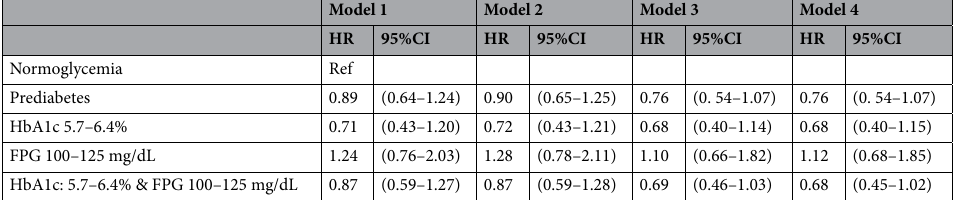
Table 4. Hazard ratio of IRF associated to prediabetes and type of prediabetes using different models. Model 1 (sex- and age-adjusted). Model 2 (Model 1 plus adjusted by lifestyle variables (i.e. smoking status, regular physical activity, high-risk alcohol consumption, adherence Mediterranean diet (MedDiet) score, and daily consumption of fruit or vegetables). Model 3 (Model 2 plus adjusted by metabolic risk factors (i.e. Waist circumference, BMI, hypertension, total cholesterol, HDL-cholesterol, triglycerides s). Model 4 (Model 3 plus adjusted by use of ACEIs or